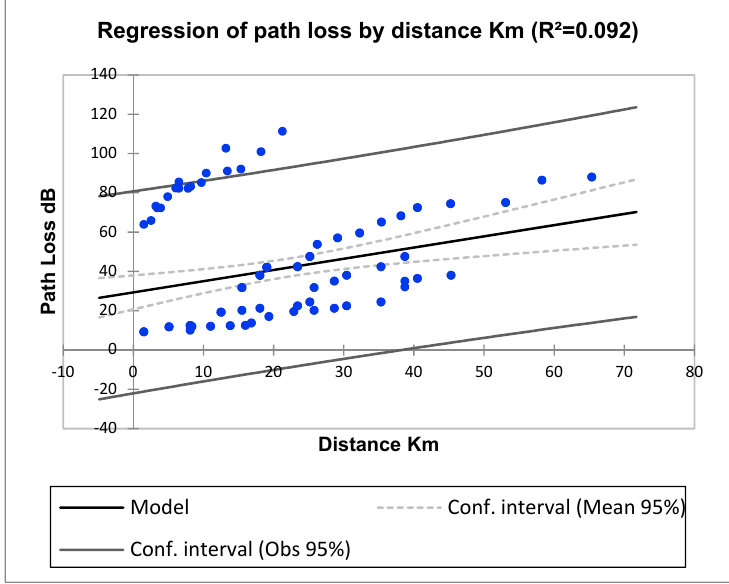
Figure 5. Regression of Path Loss by Distance.